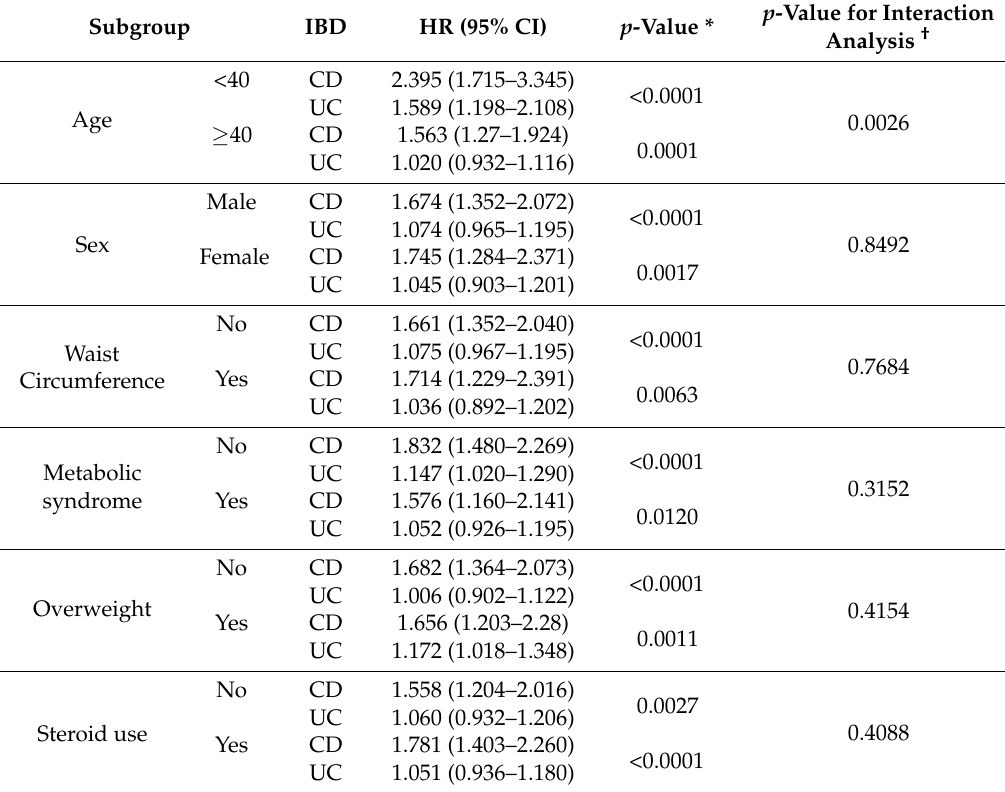
Figure 2. Incidence rate (left Y axis, column) and hazard ratio (right Y axis, line with 95% confidence intervals; CI) of diabetes in patients with inflammatory bowel disease (IBD) compared with non-IBD controls based on age group. Error bars represent 95% CIs. * Indicates p < 0.05; HR, hazard ratio; IBD, inflammatory bowel disease; UC, ulcerative colitis. Table 3. Subgroup analysis of risk for diabetes in inflammatory bowel disease.